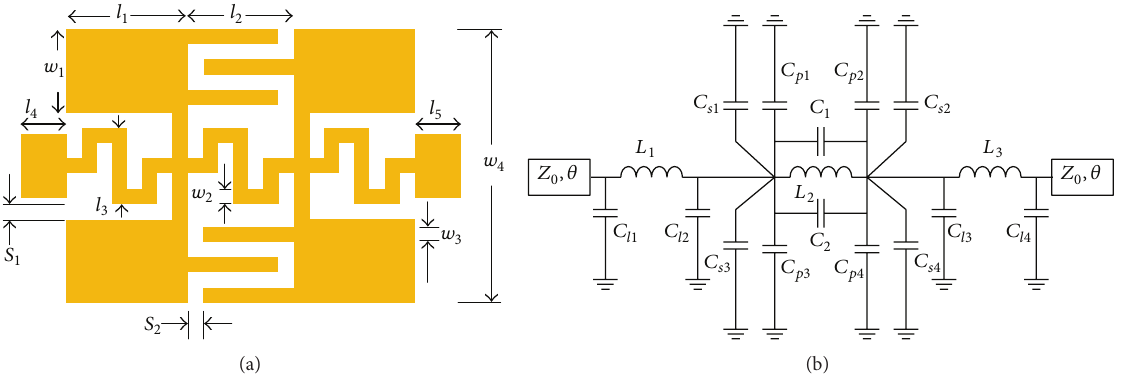
Figure 5: A unit of artificial transmission line and its equivalent circuit.